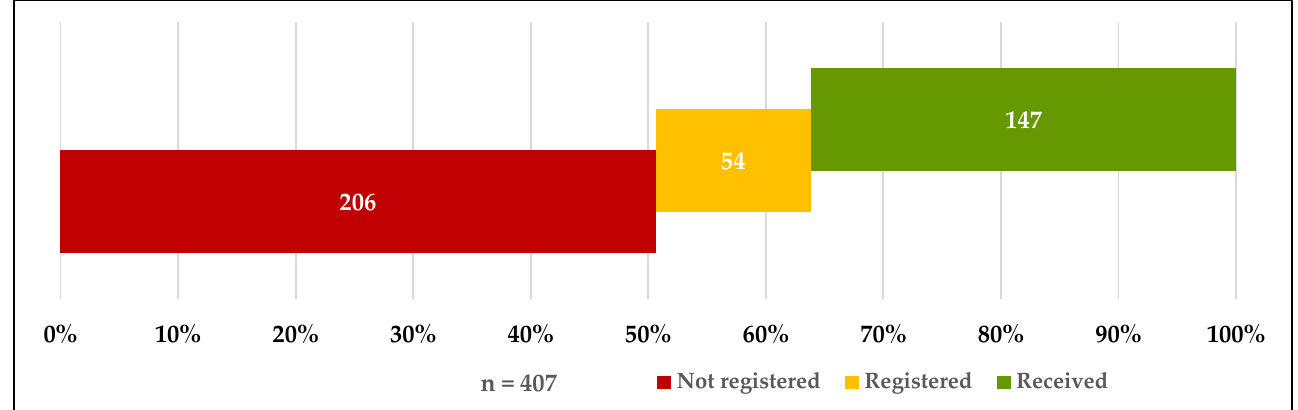
Figure 1. Participants who had received, were registered or were not registered for the COVID-19 vaccine.